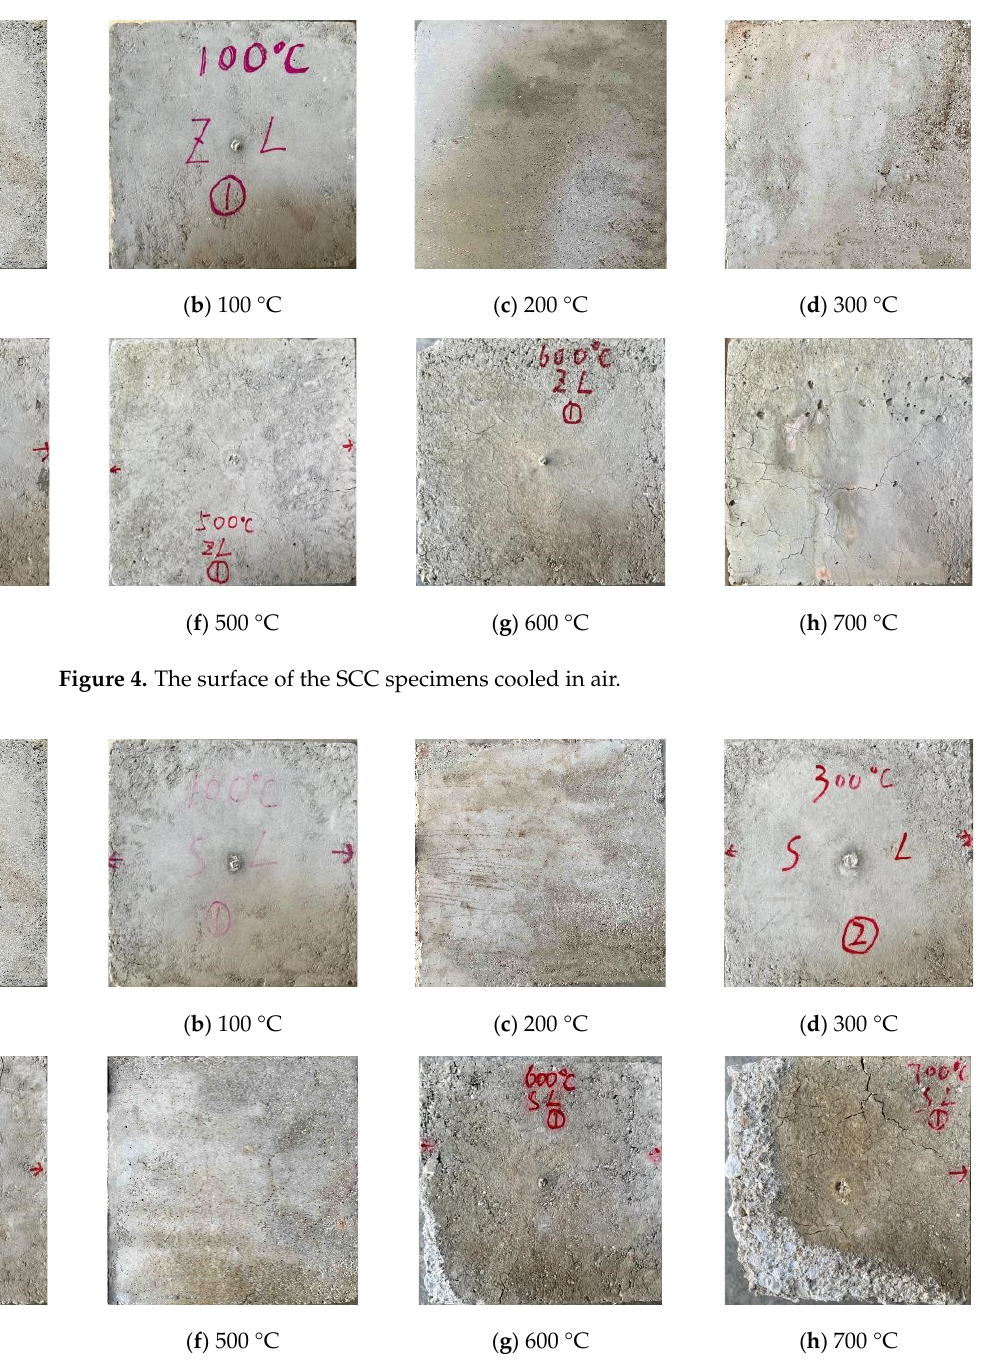
Figure 5. The surface of the SCC specimens cooled in water.